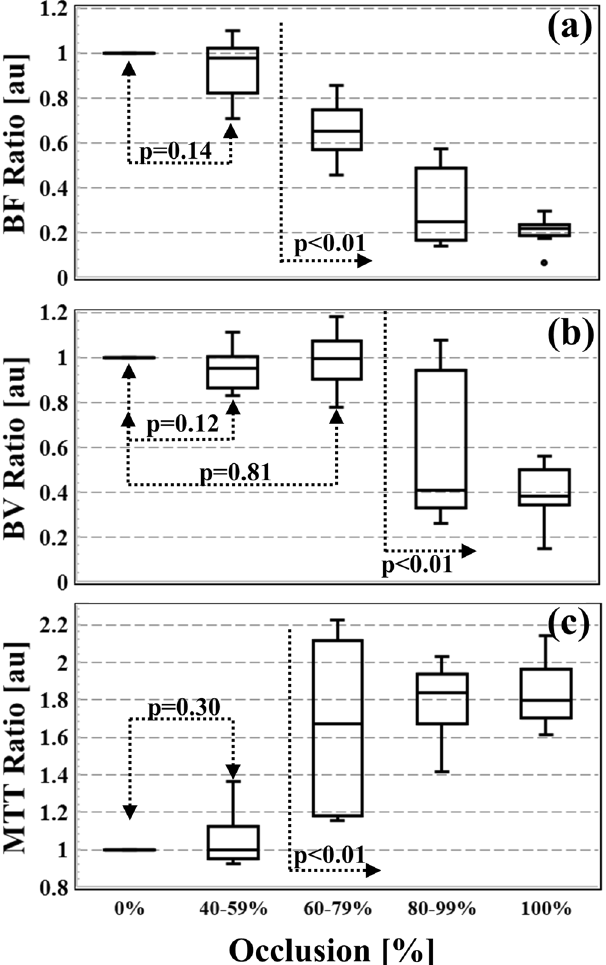
Figure 3. Box-Whisker plots of normalized perfusion ratios of blood flow ( BF , a ), blood volume ( BV , b ), and mean transit time ( MTT , c ) from all 10 pigs and all occlusions. Measurements from each occlusion category (0, 40–59, 60–79, 80–99 and 100%) are grouped and compared to baseline (0% occlusion) using paired t-test. P-values are also presented to demonstrate the statistical significance of perfusion value change compared to baseline for each occlusion